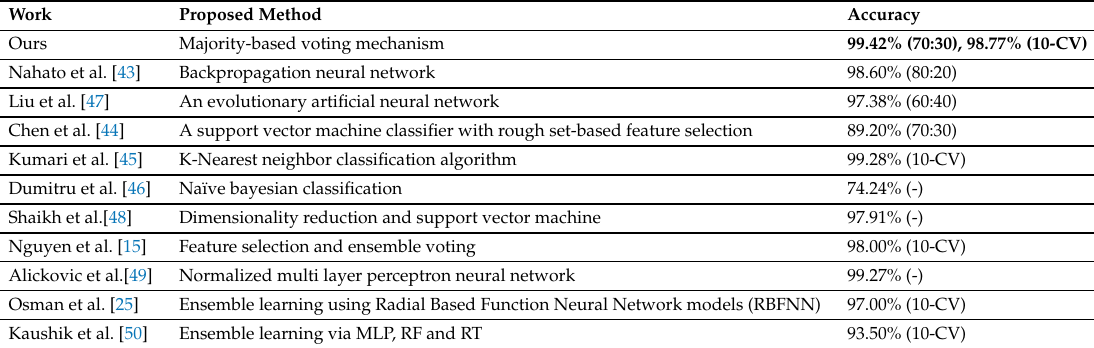
Table 4. Comparison with the existing work for breast cancer prediction using